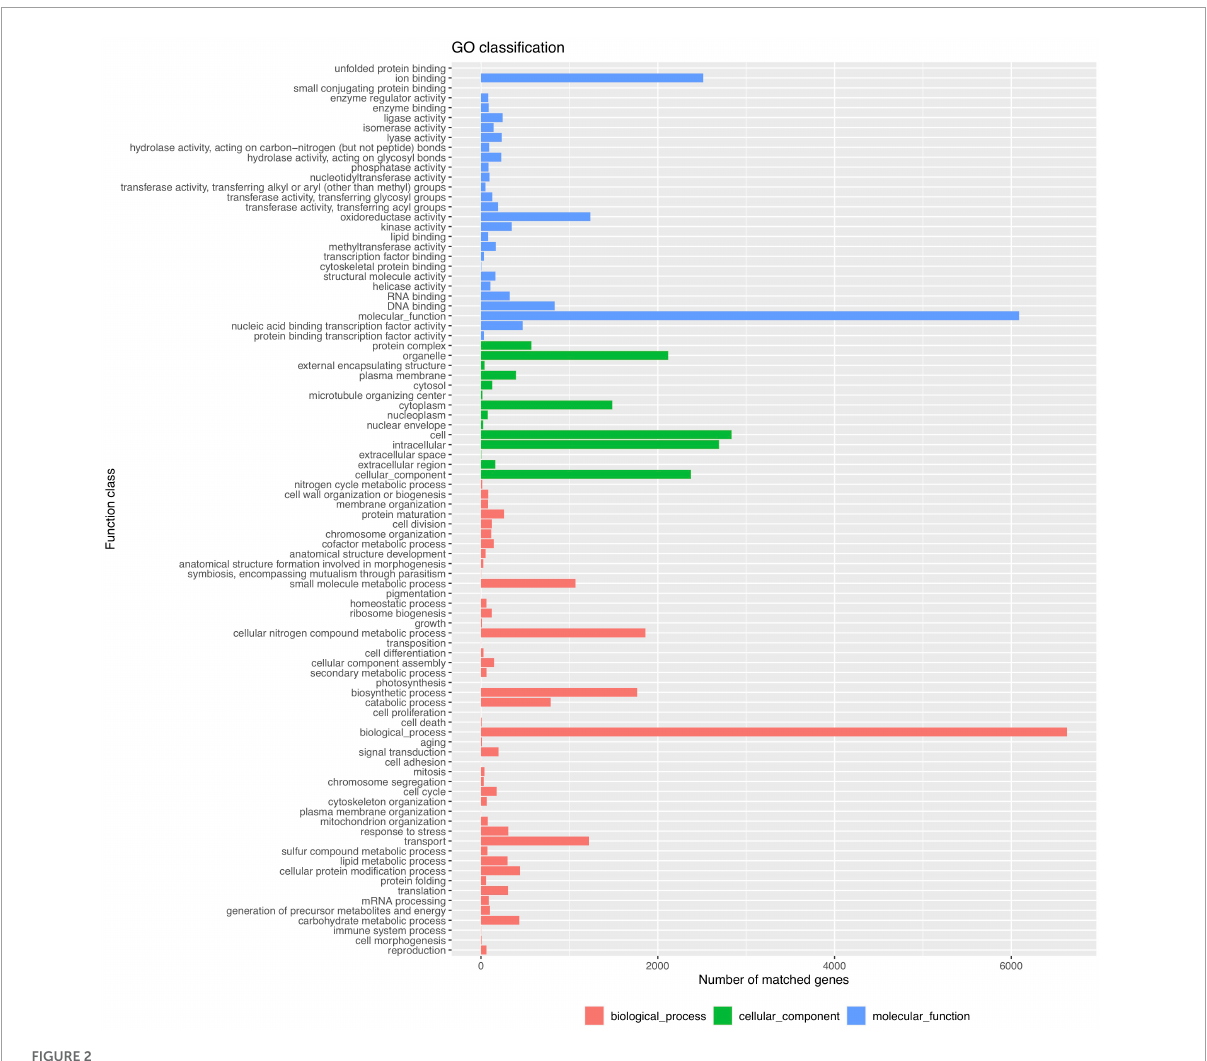
FIGURE2 Gene ontology (GO) functional classification of the Penicillium olsonii WGH5